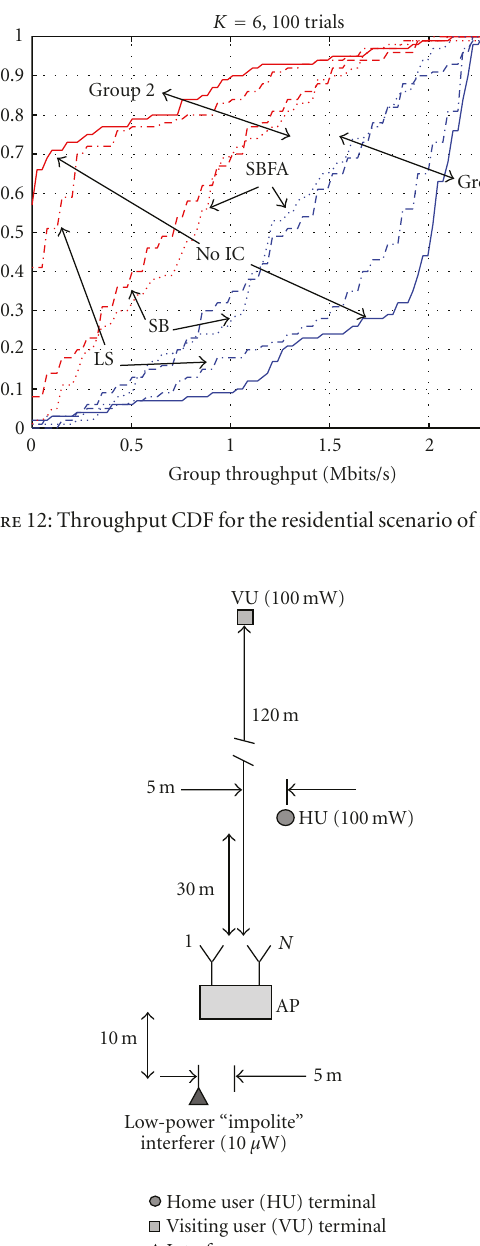
CSMA/CA for HU and VU is not a ff ected, because the in- terference power at the HU and VU locations is normally